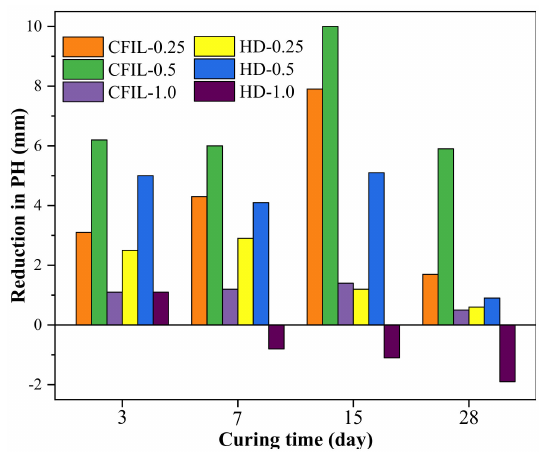
Figure 16. Decrease in PH relative to NCH-0 of each ARGF experimental